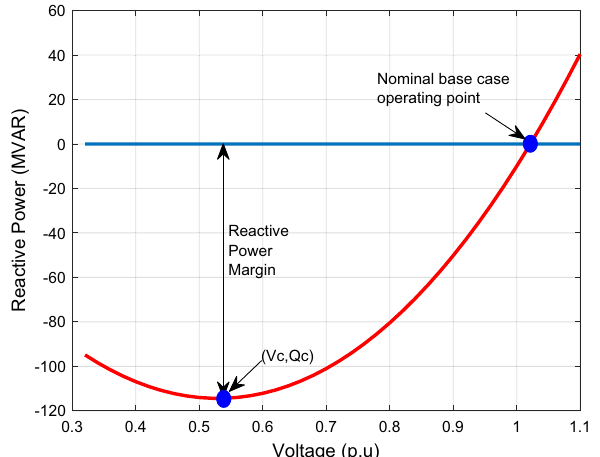
Figure 4. QV curve analysis showing RPM and